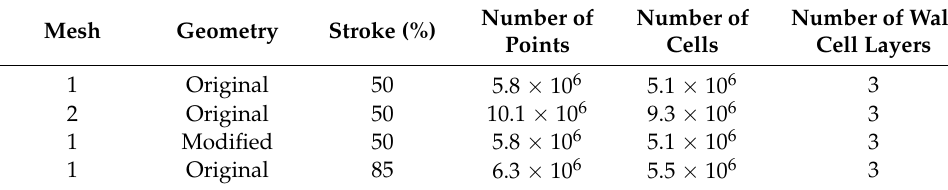
Table 1. Number of points, cells and boundary cell layers for each mesh.